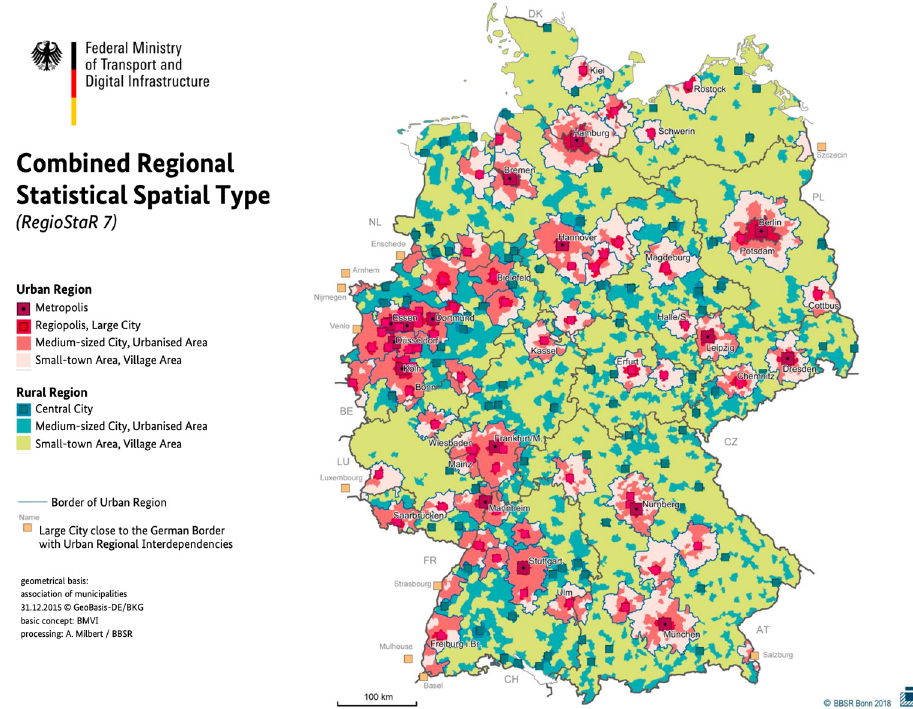
Figure 4. Geographical representation of the seven area types (RegioStar 7) in Germany for the research in mobility and transportation sectors [29], with permission from Federal Ministry of Transport and Digital Infrastructure, 2018.